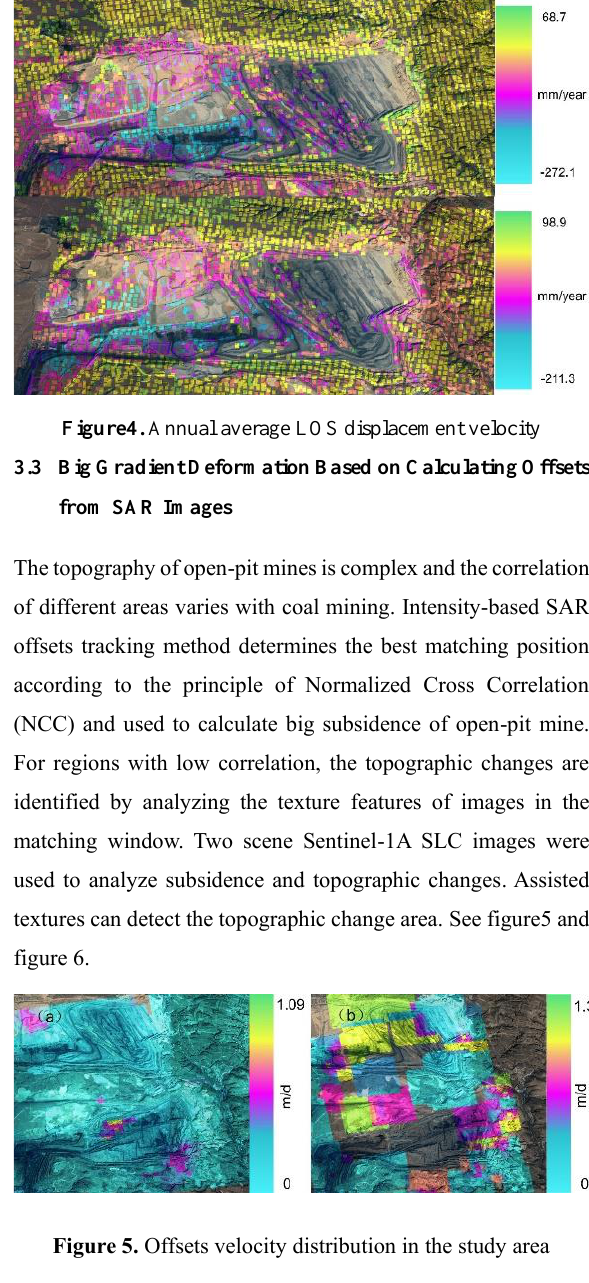
Figure 7. 3D visualization deformation monitoring effect after data